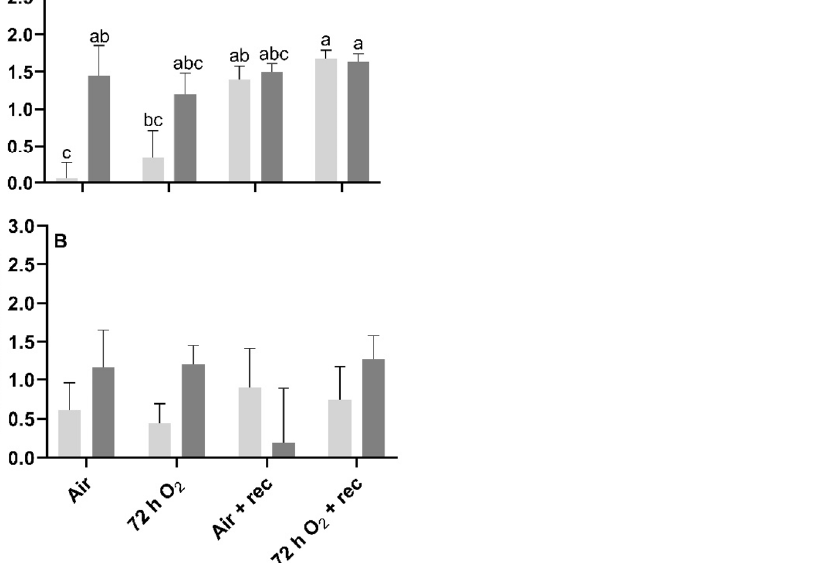
Figure 5. Effect of Nrf2 deletion on lung DNA lesions in mice exposed to neonatal hyperoxia. recovery. Lesions in lung mitochondrial (mtDNA, ( A )) and nuclear DNA (nDNA, ( B )) were determined in mouse neonates exposed to 72 h room air (Air) or 72 h hyperoxia (>95% O 2 ,72 h O 2 ) from postnatal day (PND) 1 to 4 and the neonatal air- or O 2 -exposed mice recovered in room air for 5 wks (Air + 5 wk rec, 72 h O 2 + rec) using PCR (lesions per 10 kb for mtDNA or per 6.5 kB for nDNA). Mean ± S.E.M. presented ( n = 3–5/group). A Two-way ANOVA was employed with genotype ( Nrf2+/+ , Nrf2 − / − ) and exposure (Air, 72 h O 2 , Air + rec, 72 h O 2 + rec) as the factors. Letters were used when there were significant main effects ( p < 0.05). Bars not connected by the same letter are significantly different ( p <